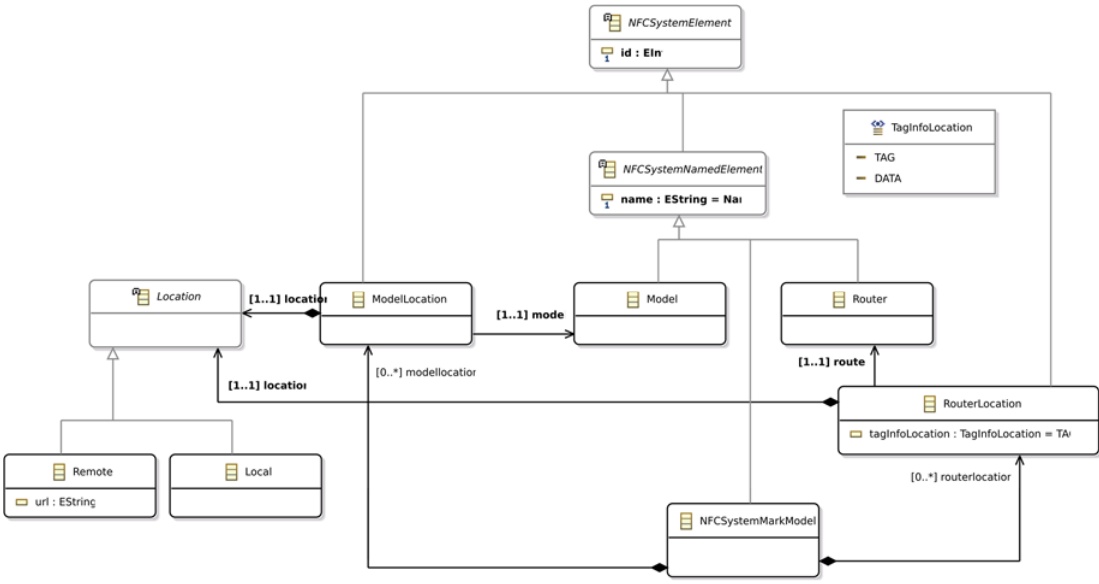
Figure 4. Marking model to define the Platform Specific Model.